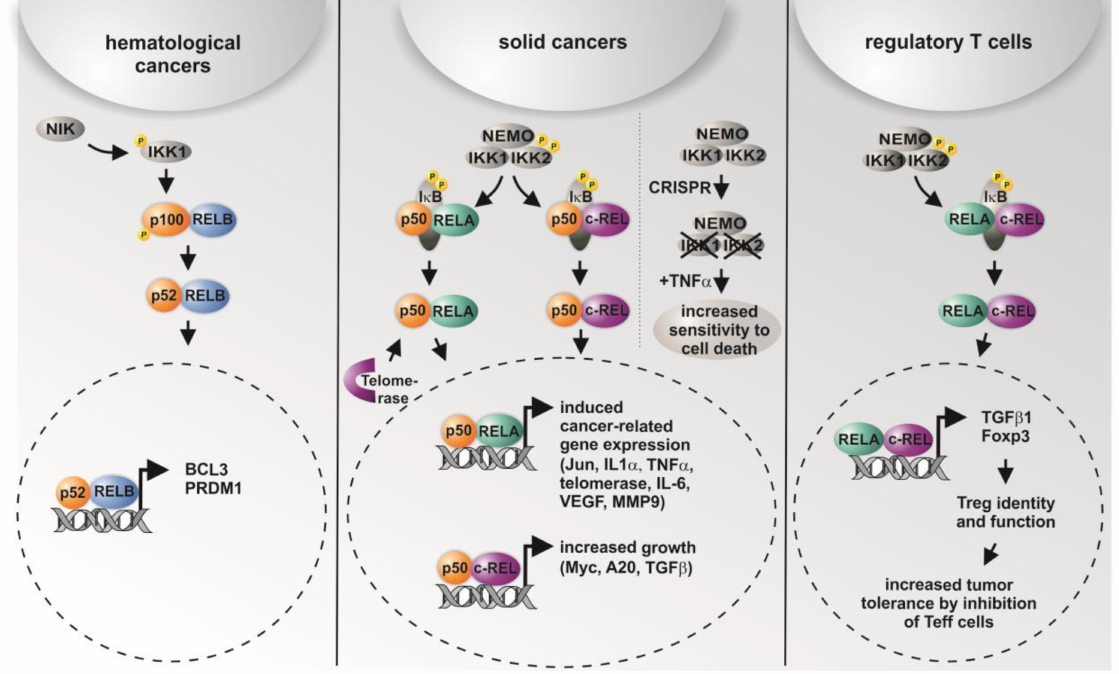
Figure 2. Graphical overview on the differential roles of NF- κ B subunits and their transcriptional activity in distinct types of cancer and in regulatory T cells. While non-canonical signaling is mostly present in hematological cancer, solid cancer shows predominantly canonical signaling via p50/RELA or p50/cREL. In addition, CRISPR/Cas-mediated double knockout (KO) of IKK1/2 was recently shown to result in increased sensitity to TNF- α -mediated cell death [38]. In regulatory T cells (Tregs), activation of RELA/cREL results in distinct target gene expression leading to active Tregs inhibiting effector T cells (Teff), which infiltrate the tumor